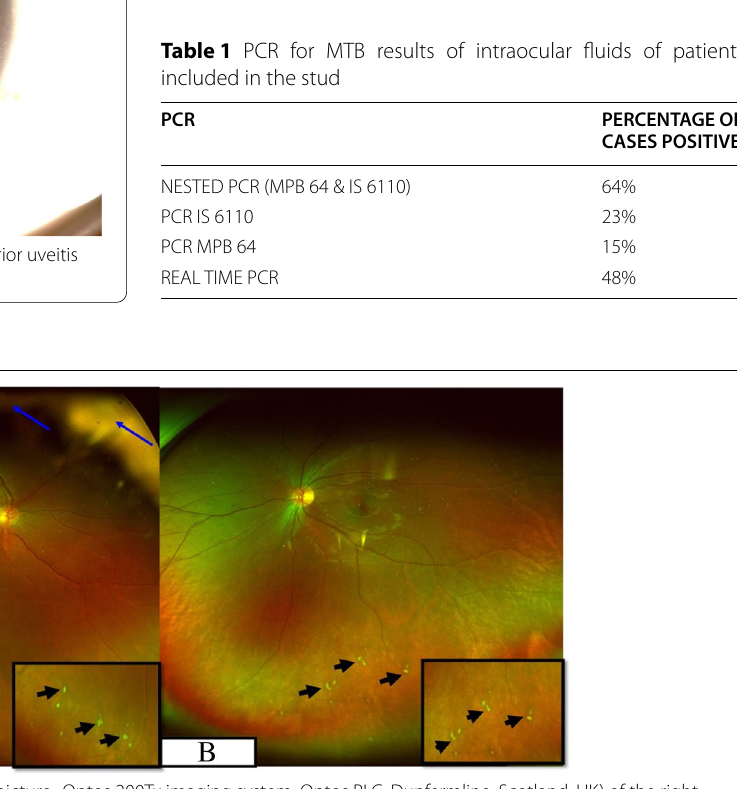
Fig. 2 Wide-field fundus photo (pseudocolour fundus picture- Optos 200Tx imaging system, Optos PLC, Dunfermline, Scotland, UK) of the right eye ( A ) and left eye ( B ) of a patient whose aqueous sample was tested positive for PCR MTB. It showed relatively clear media with snowball vitreous exudates (black arrowheads) and attached retina. The right eye also had peripheral vitreous membranes (blue arrow)